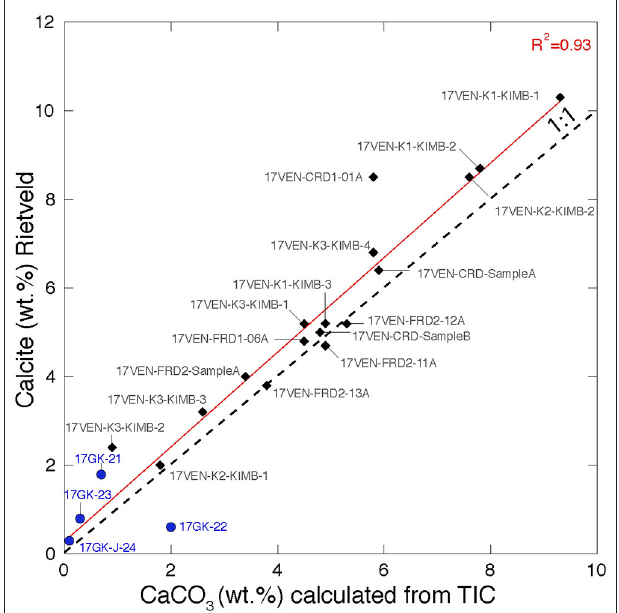
FIGURE 3 | Biplot representing CaCO 3 abundances calculated from bulk TIC analyses (measured by coulometry) vs. the calcite content (wt.%) determined by Rietveld refinement. The R 2 of the regression line is 0.93 and close to the 1:1 line supporting the accuracy of the calcite estimation using Rietveld refinement. Samples from Venetia are represented by black diamonds and samples from Gahcho Kué are represented by blue circles. Samples from the Gahcho Kué mine are calcite and